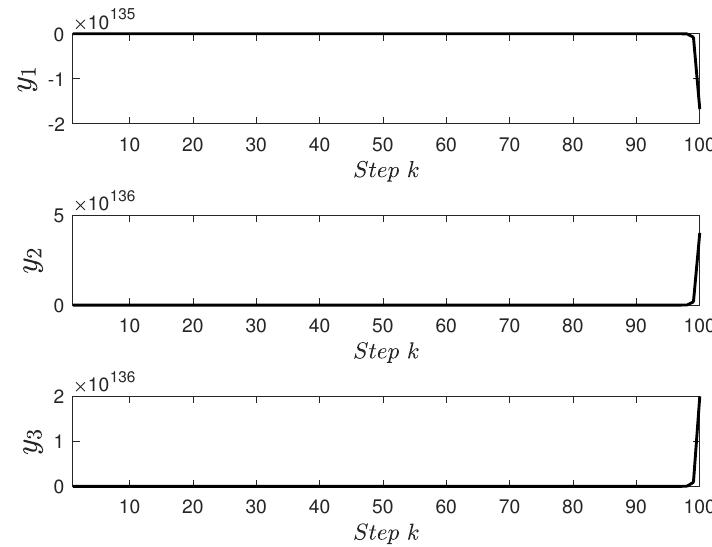
Figure 9. Outputs of